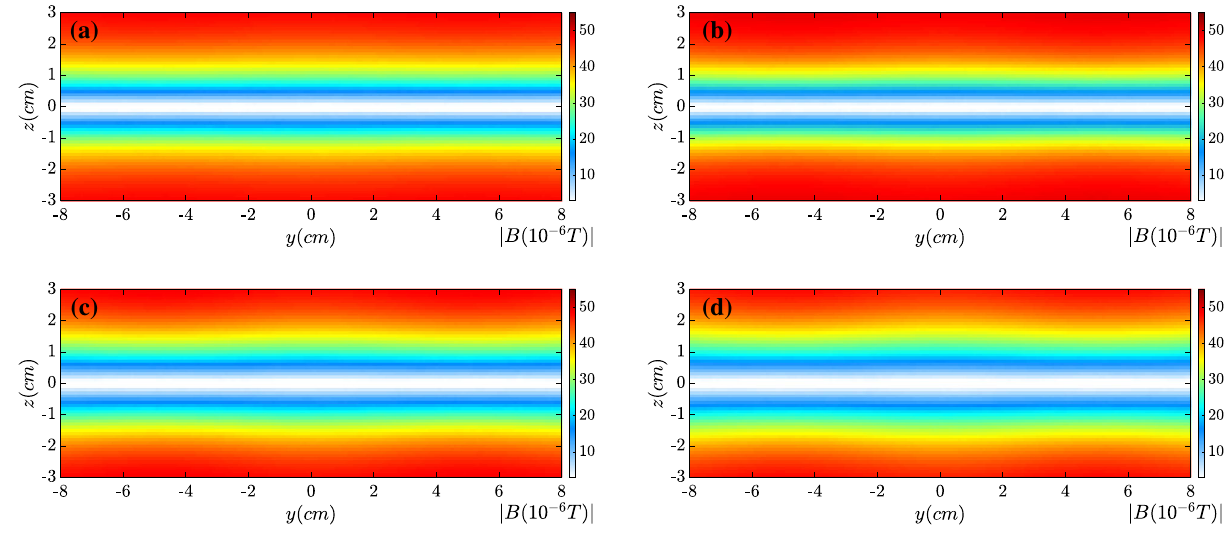
Figure 8. Distribution of magnetic field strength along x = 0 at ( a ) t = 0.3 µ s , ( b ) t = 0.5 µ s , ( c ) t = 0.7 µ s and ( d ) t = 0.8 µ s . By the electron wobbling motion along y , magnetic reconnection is mitigated well.